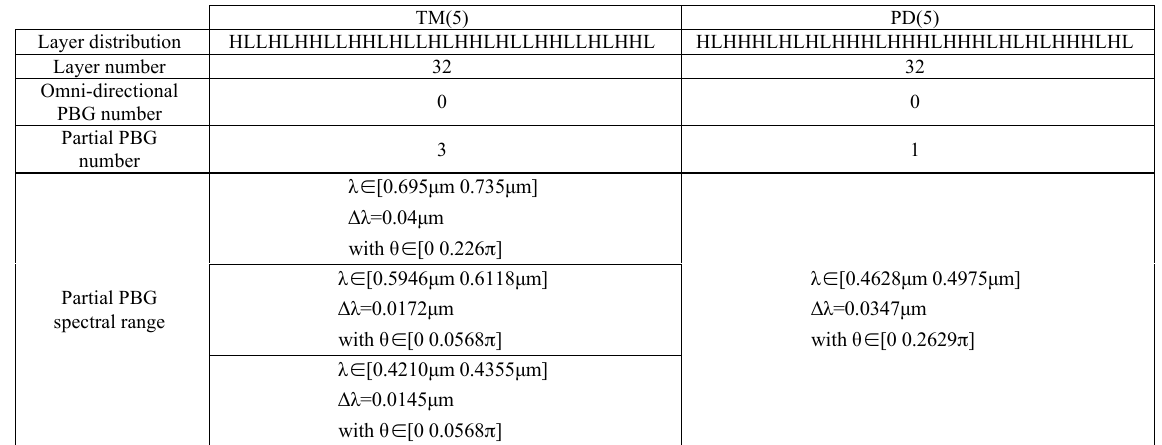
Table 1: Structural and optical aspects of the two photonic systems TM (5) and PD